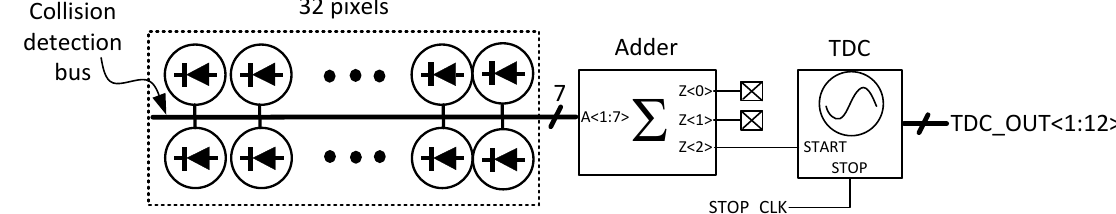
Figure 21. Proposed sensor architecture with coincidence event detection among 32 pixels, based on collision detection bus.